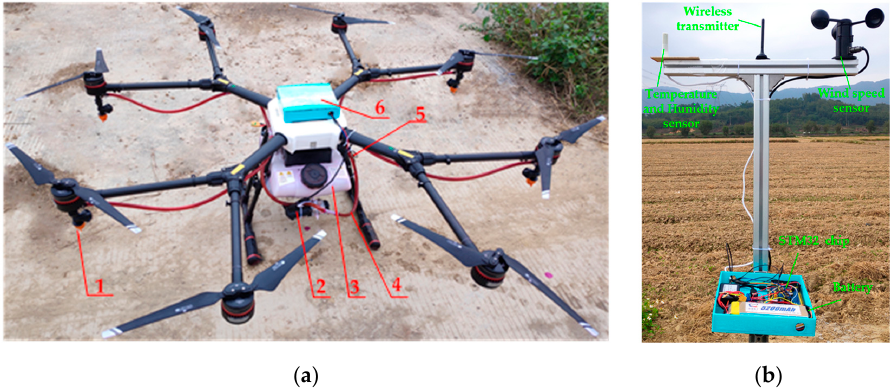
Figure 10. The physical drawings of the system. ( a ) Variable rate spray system based on BP neural network decision. ( b ) Environmental meteorological collection module. Note: (1) Pressure nozzle. (2) Micro-diaphragm pump. (3) Medicine box. (4) Compression pipe. (5) Wireless transmission station.